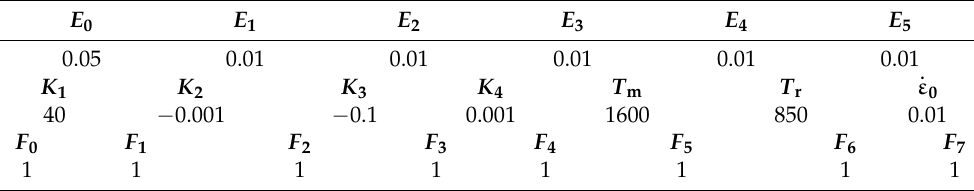
Table 3. The initial material parameters of TA31 for the modified JC model.